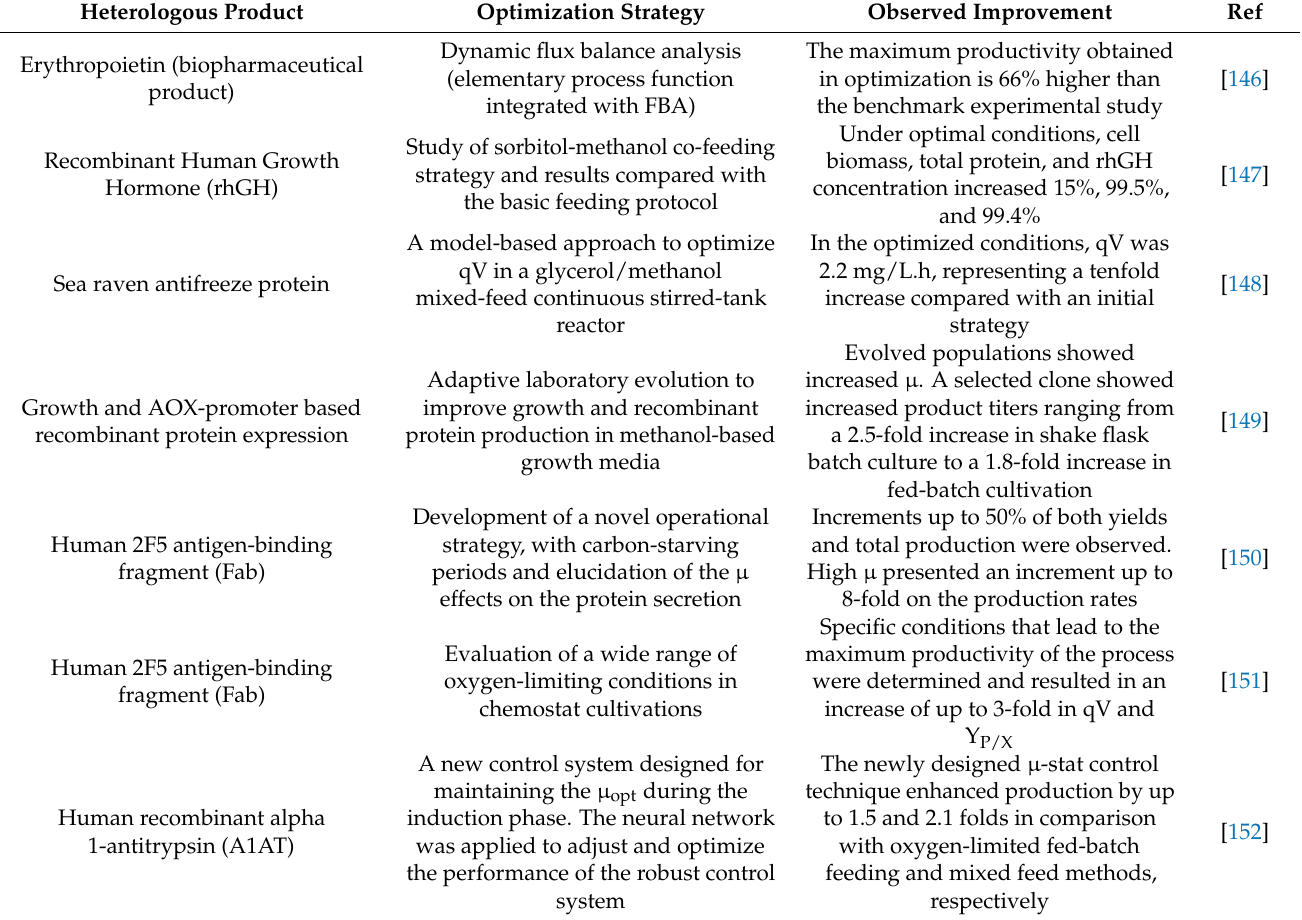
Table 5. Strategies for process development, simulation, and optimization with K. phaffii